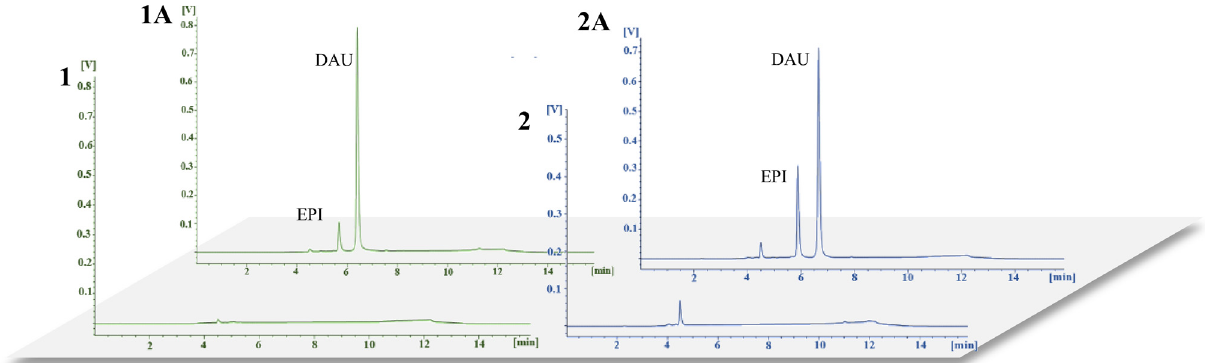
Figure 2. Representative chromatograms for ( 1 ) blank plasma samples and ( 1A ) plasma samples enriched with EPI (0.1 µg/mL) and DAU (0.5 µg/mL), and for ( 2 ) blank urine samples and ( 2A ) urine samples enriched with EPI (0.5 µg/mL) and DAU (1.0 µg/mL).